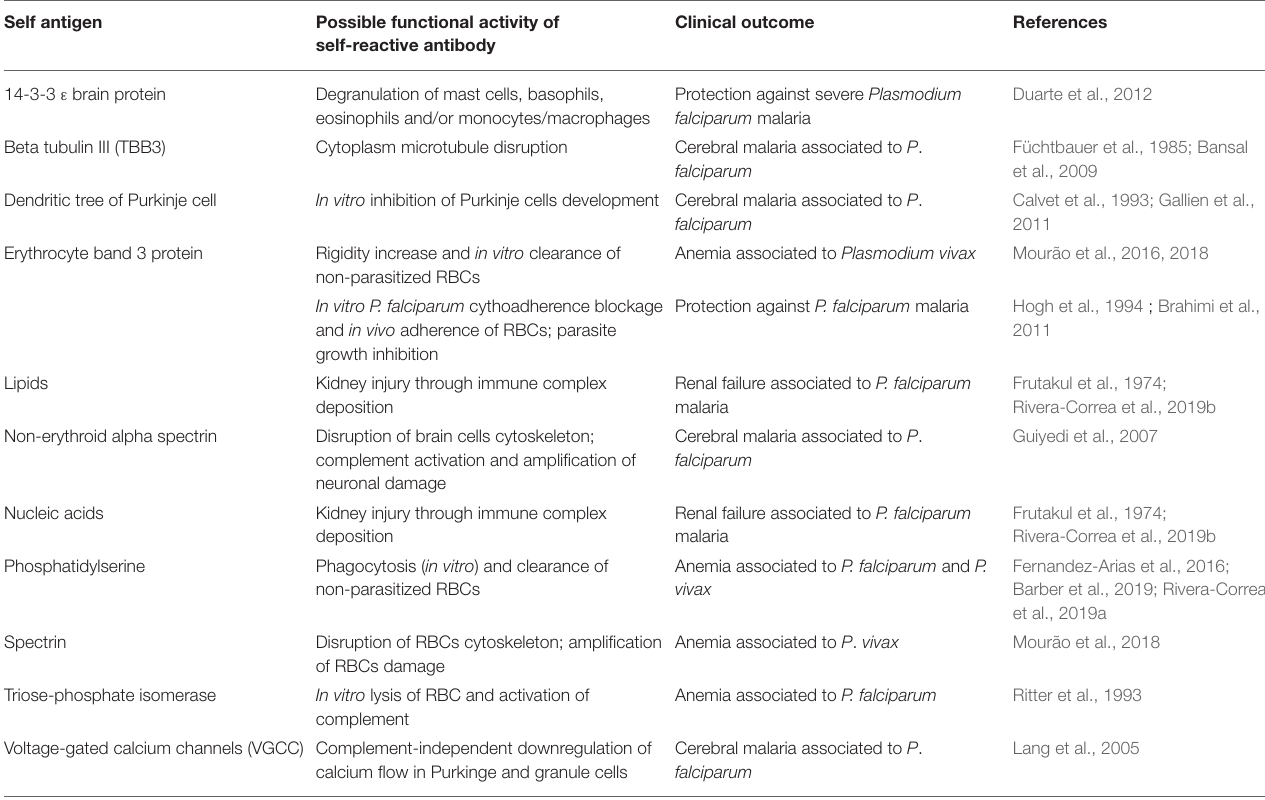
TABLE 1 | Autoantibodies against self-antigens and their implications in P. falciparum and P. vivax